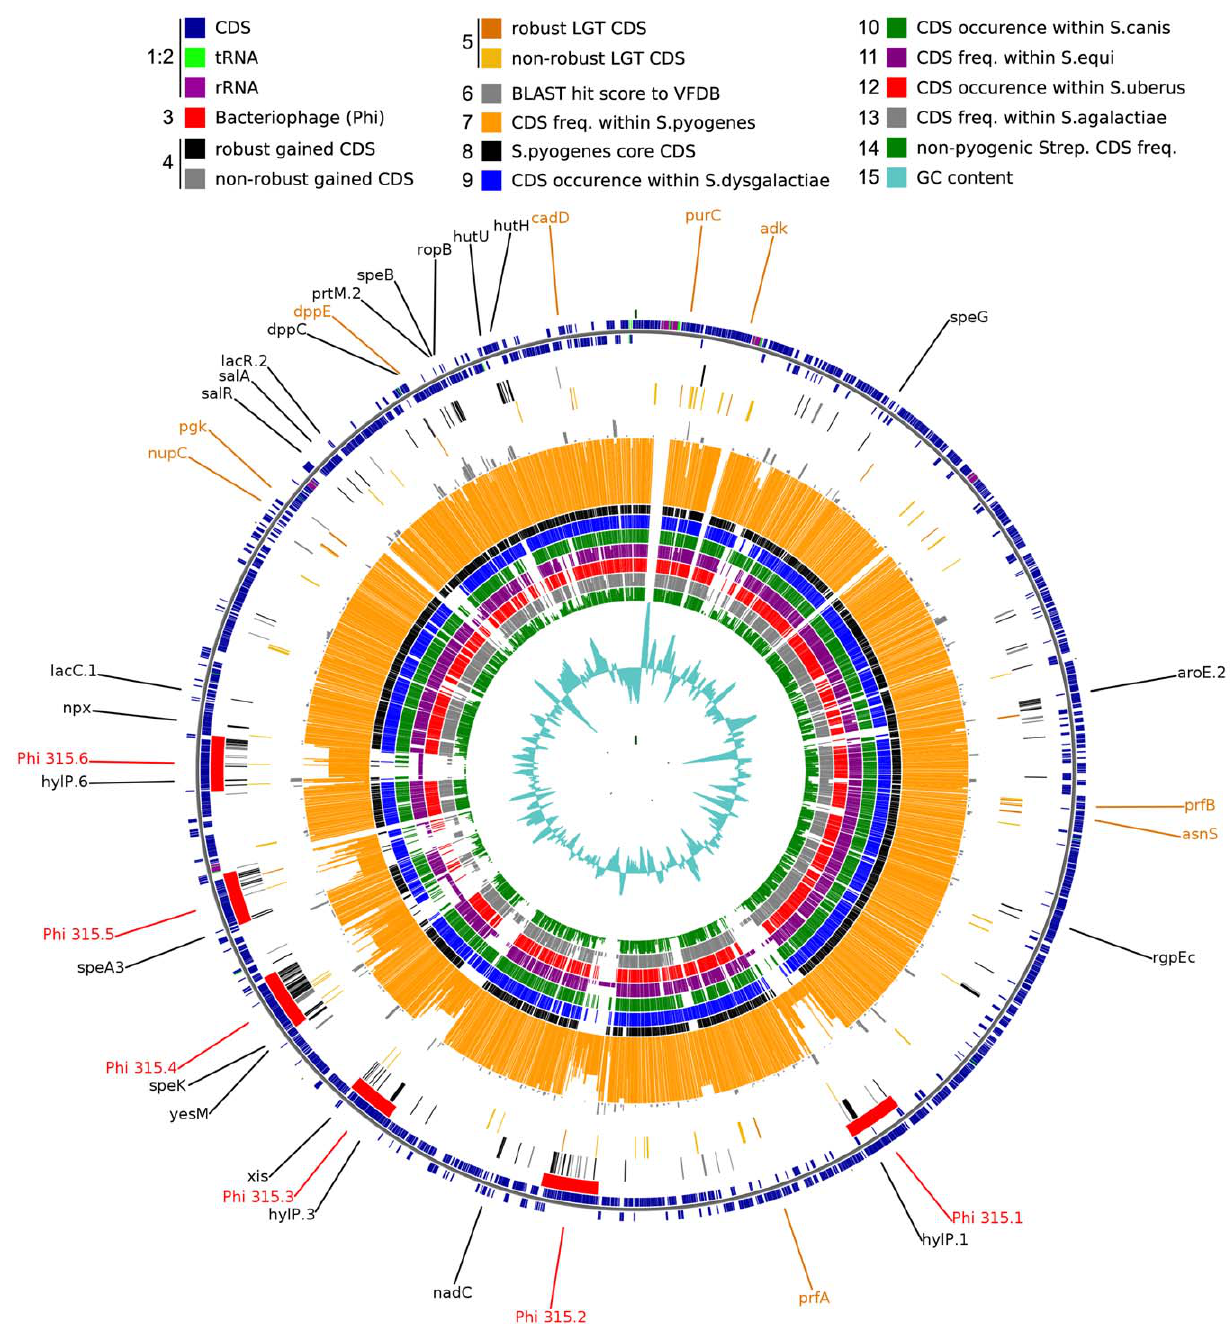
Figure 4. Circular map of the S. pyogenes MGAS315 genome showing location of gained and LGT genes. A color legend for each ring (1 to 15) appears at the top of the figure. The figure highlights the S. pyogenes core-genome distribution (tracks 7 and 8) and islands of gained genes (tracks 3 and 4). MGAS315 is chosen simply as a reference genome to map the results of the analysis.